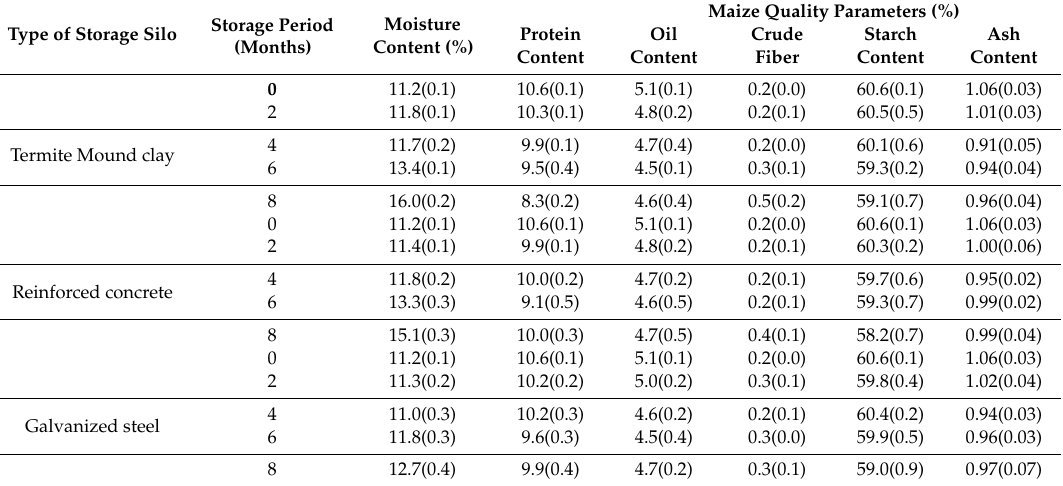
Table 4. Variations in grain quality parameters in termite mound clays, reinforced concrete, and galvanized steel silos